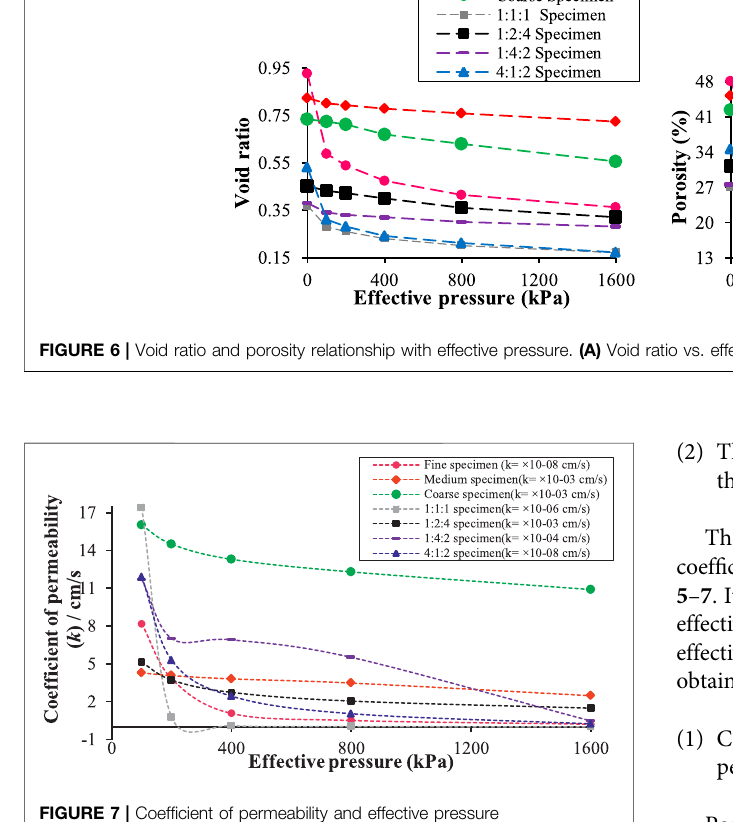
FIGURE 7 | Coef fi cient of permeability and effective pressure